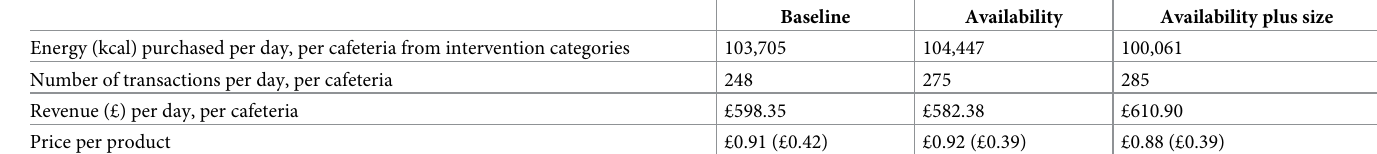
Table 3. Unadjusted data (mean [SD]) for purchases, revenue, and prices in cafeterias during intervention periods.